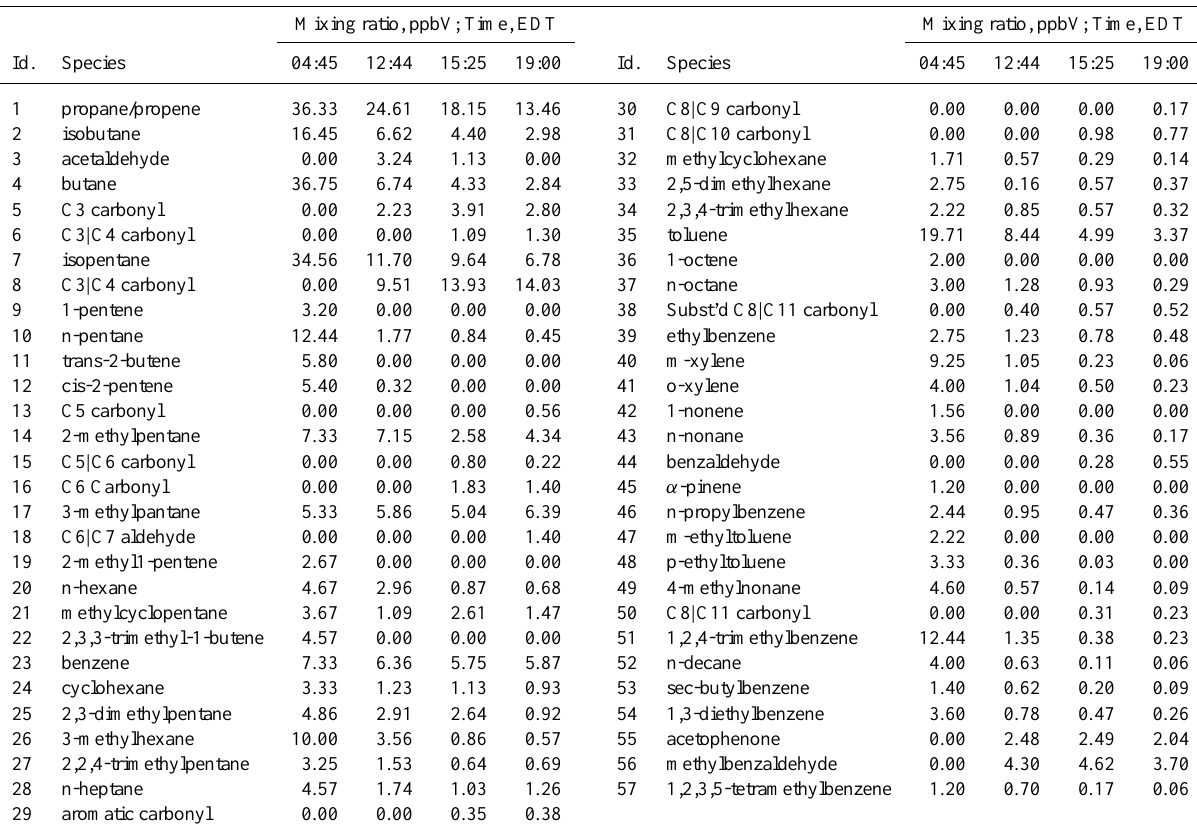
Table 4. GCMS Measured VOC species at four times during experiment III (JN2509) using SynUrb54/NO x in Gillings Outdoor Chamber. See Fig. 5 for the corresponding